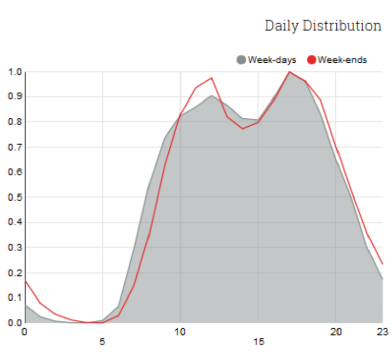
Figure 6. Daily distribution. Distribution of presences by time of the day, stratified for weekdays and weekends.